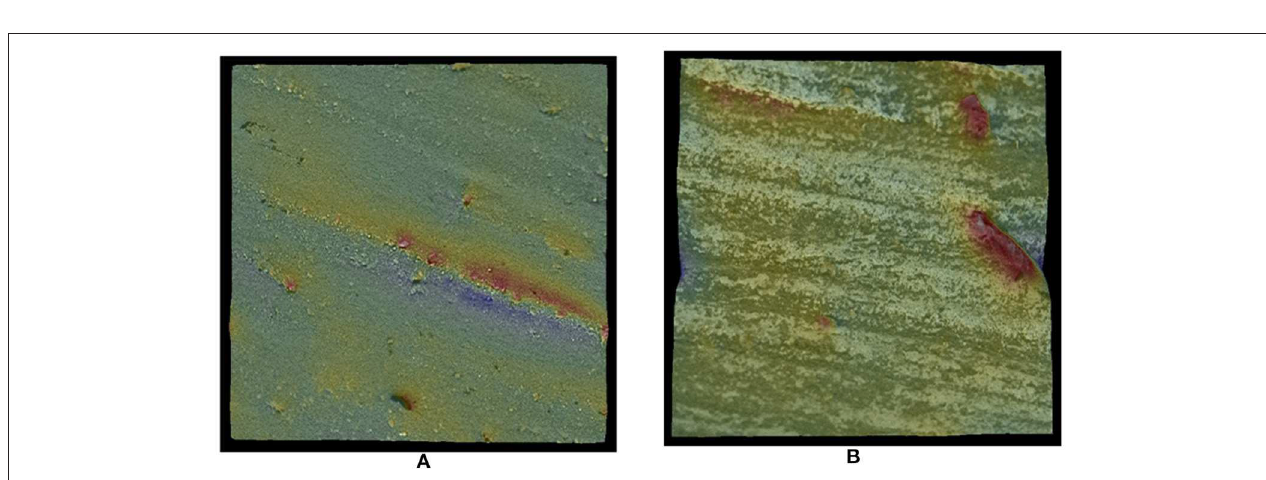
FIGURE 4 | SEM topographical images of the etched surface of (A) the undrawn filament and (B) the filament drawn at 100 ◦ C and DR = 5.5.